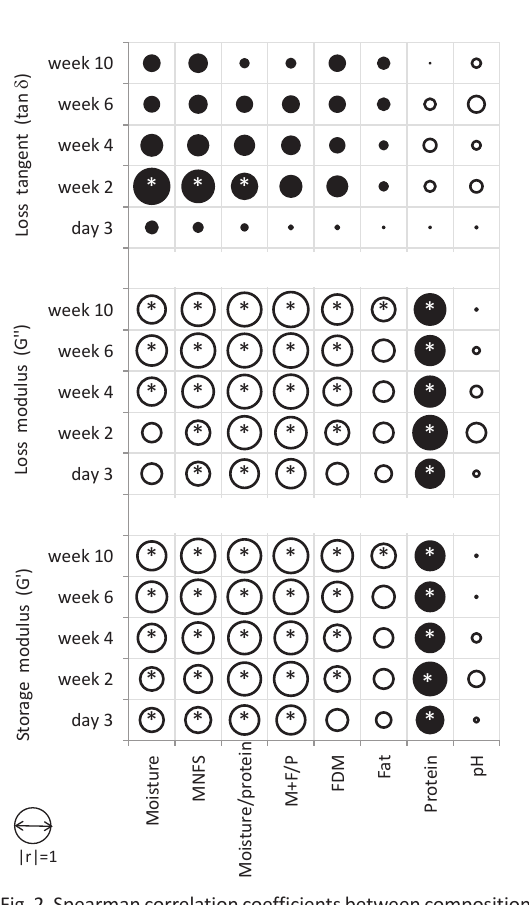
Fig. 2. Spearman correlation coefficients between compositional and rheological parameters by week of aging. White circles represent negative, black circles positive correlation coefficients, diameter of circles correspond to value and * indicates statistical significance ( p <0.05). (MNFS = moisture in non-fat substance, M+F/P = moisture plus fat to protein ratio, FDM = fat in dry